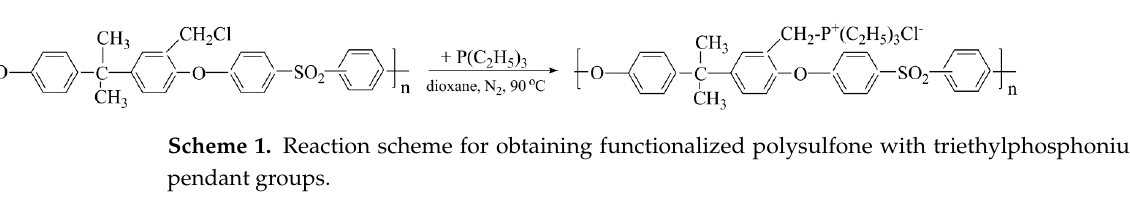
Figure 2. Work diagram: Stages of the experimental protocol.